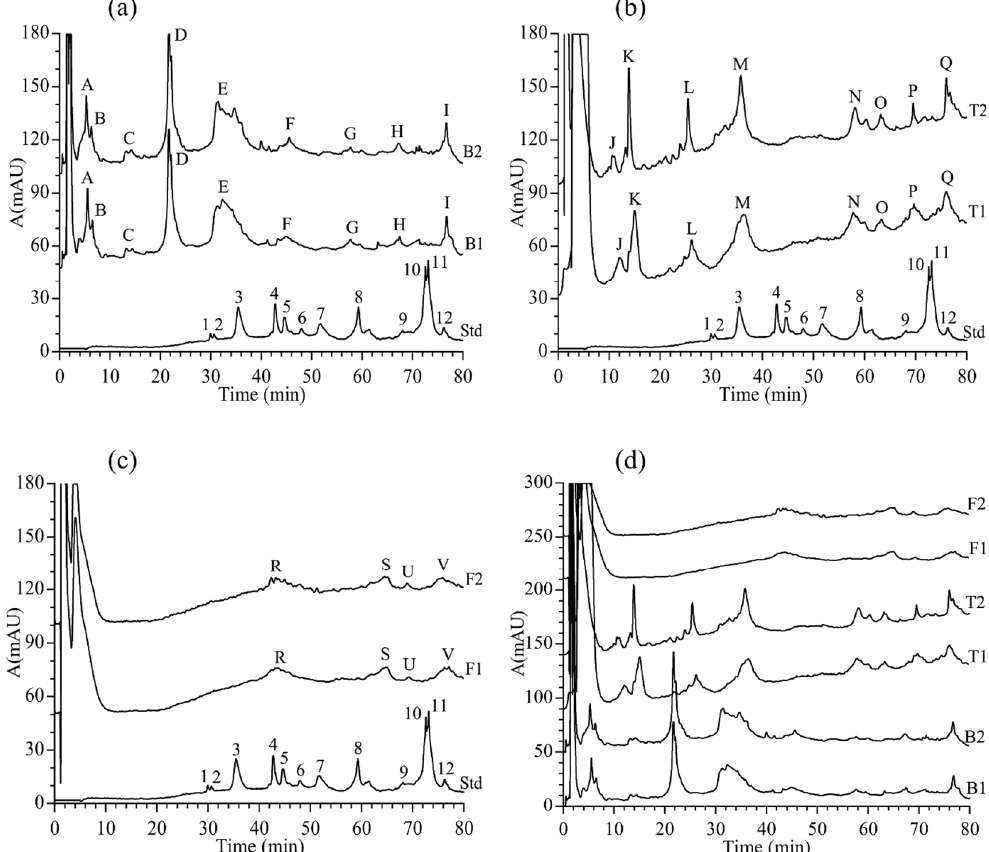
Figure 4. The comparison of Ranae Oviductus and counterfeit products. ( a ) Comparison of the protein HPLC fingerprint chromatogram of Ranae Oviductus (Std) and protein HPLC fingerprint chromatograms of the bullfrog oviduct (B1, B2). ( b ) Comparison of the protein HPLC fingerprint chromatogram of Ranae Oviductus (Std) and the protein HPLC fingerprint chromatograms of the toad oviduct (T1, T2). ( c ) Comparison of the protein HPLC fingerprint chromatogram of Ranae Oviductus (Std) and the protein HPLC fingerprint chromatograms of the frog oviduct (F1, F2). ( d ) Comparison of the protein HPLC fingerprint chromatograms of three counterfeits (bullfrog oviduct, toad oviduct, frog oviduct) of Ranae Oviductus .